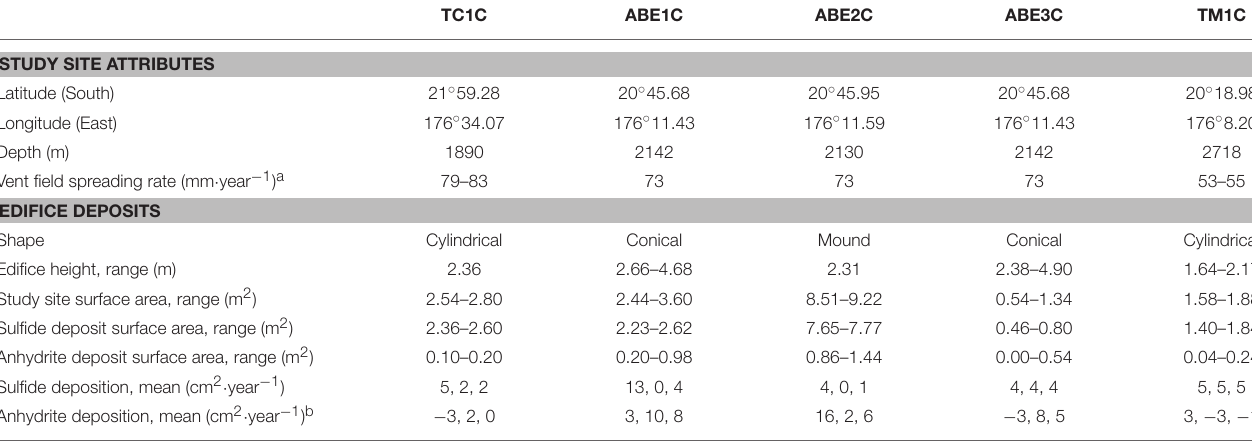
TABLE 1 | Attributes of the long-term study sites on five active hydrothermal vent edifices in the Tow Cam (TC), ABE, and Tu’i Malila (TM) vent fields, and changes over